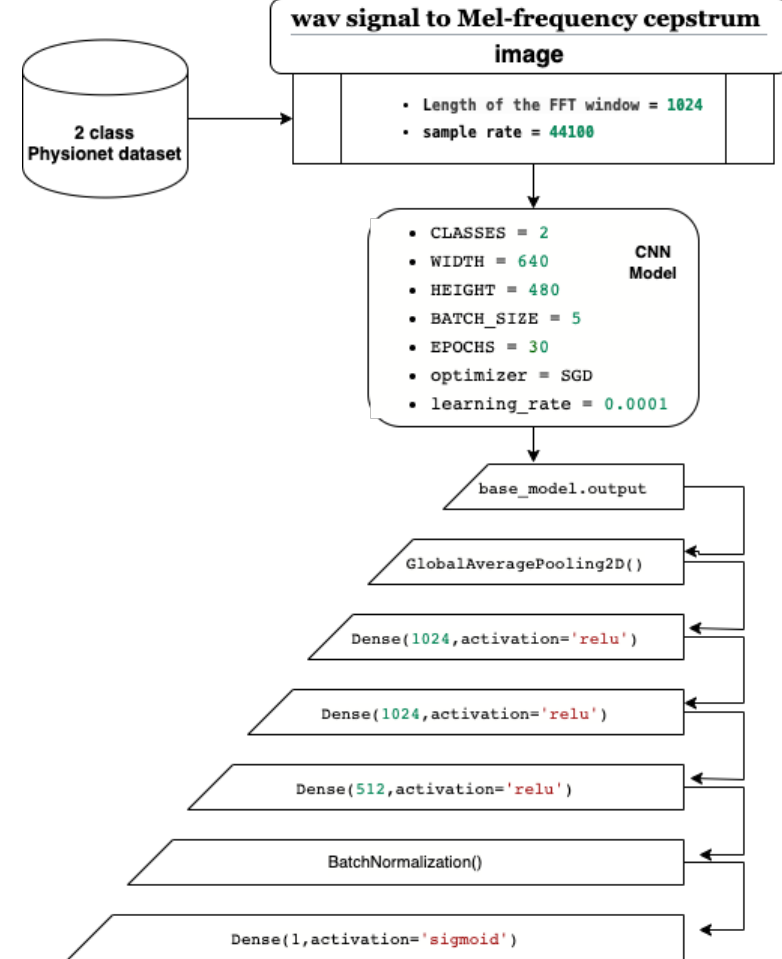
Figure 16. The architecture of our CNN